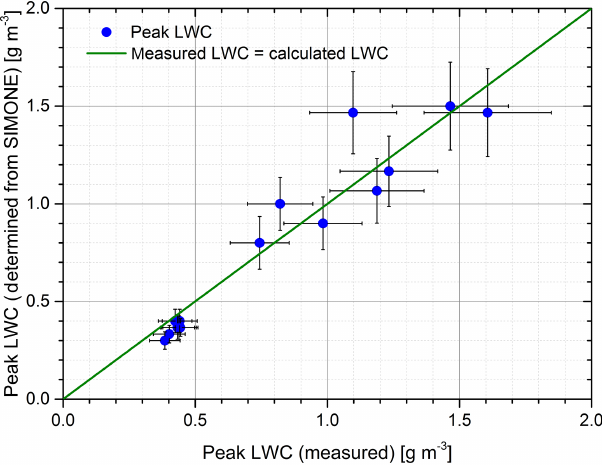
Figure 2. A comparison of the SIMONE-derived and measured (MBW total water minus TDL gas phase water) peak condensed water during CLOUD9